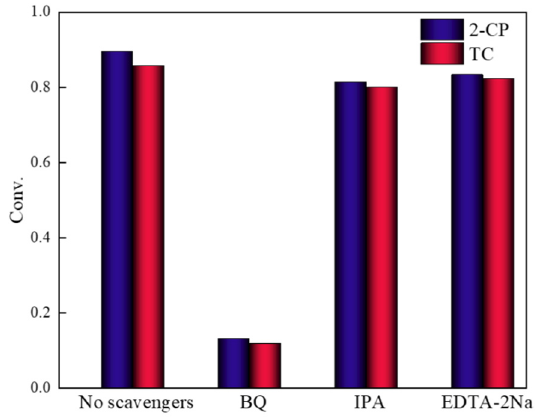
Figure 11. Scavenger experiments.